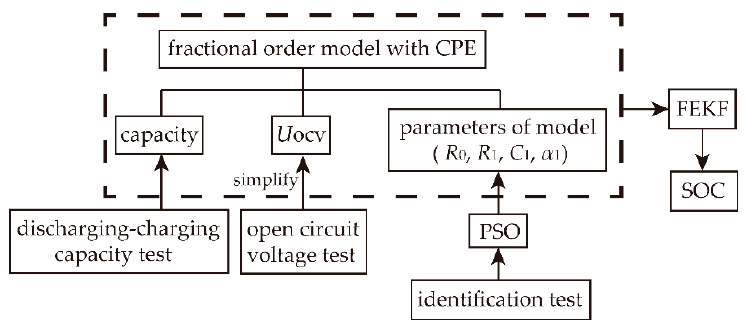
Figure 1. Structure of the article.